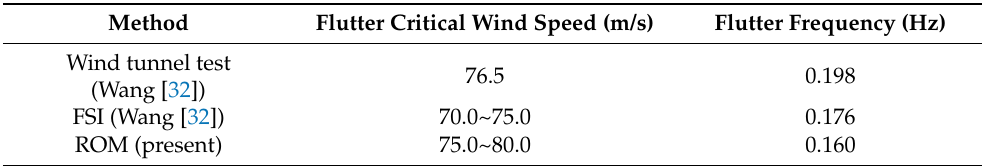
Table 6. Comparisons of flutter results of the girder of